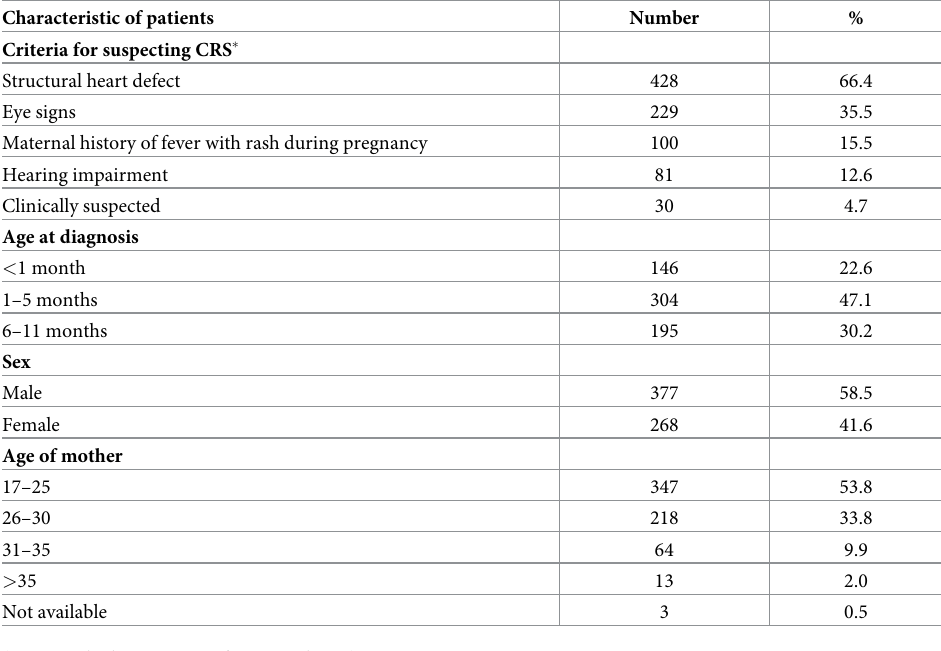
Table 1. Characteristics of suspected cases of congenital rubella syndrome (CRS), Congenital Rubella Surveillance System, India, November 2016–December 2018 (N = 645). Characteristic of patients Number % Criteria for suspecting CRS